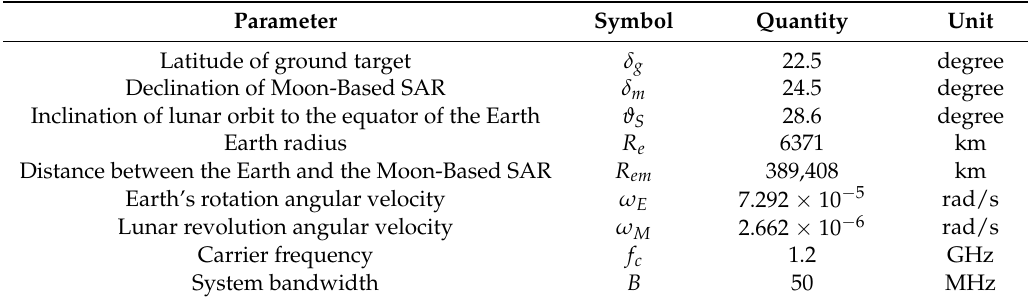
Table 1. Simulation